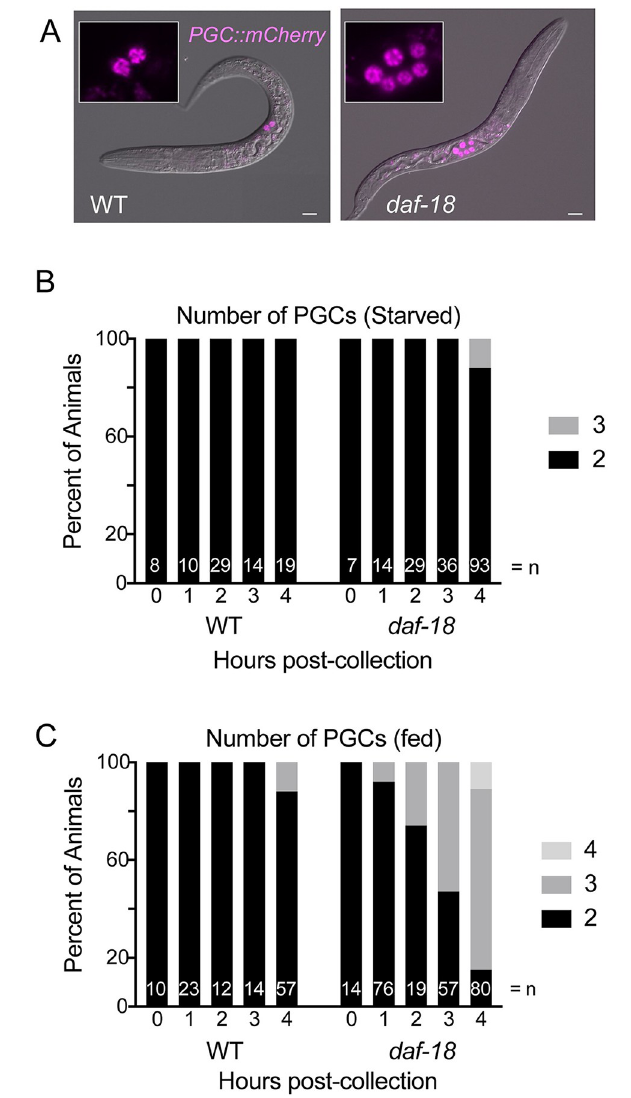
Fig 1. DAF-18 promotes PGC quiescence in both fed and starved larvae. (A) Wild type (WT) and daf-18(ok480) mutant L1 larvae, starved for 3 days after hatching, show 2 or an average of 6 primordial germ cells (PGCs), respectively. The marker PGC :: mCherry ( naSi2 ) is expressed in the PGCs (and in ~10% of animals, expression is seen in one additional cell in the head). Scale bar represents 10 μ m. (B) and (C), Animals were synchronized within 2 hours of hatching and monitored for PGC divisions during starvation (B) and in the presence of food (C). Summary of 2 replicate experiments.